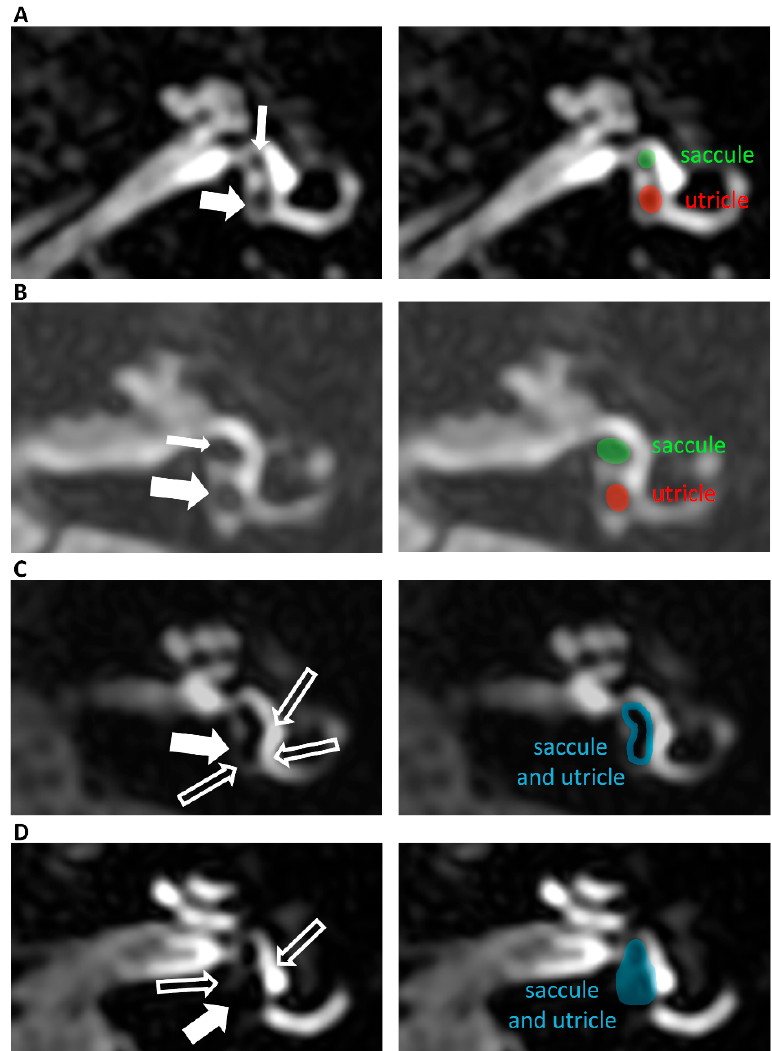
Figure 2. Delayed post-contrast 3D-FLAIR axial images of left ears below the mid-modiolar level (inferior part of the vestibule). The right side images on panel ( A – D ) show the same images as the left ones in respective panels but in the form of companion scans with some line art applied to define specific anatomical structures for easier identification of observed pathologies. Panel ( A ) presents a normal vestibule—grade 0 where non-enhancing the saccule (thin arrow) and utricle (thick arrow) are easily visible in the enhancing vestibule. The saccule is smaller than the utricle. Panel ( B ) presents extra low-grade, that is, grade 1 vestibular endolymphatic hydrops on Bearnaerts scale (but still grade 0 on Barath scale) where the saccule (thin arrow) and utricle (thick arrow) are well separated; however, the saccule is larger than the utricle, and the enhancing vestibule is seen around them. Panel ( C ) shows grade 2 vestibular endolymphatic hydrops on Bearnaerts scale (grade 1 on Barath scale) where the saccule and utricle are enlarged and confluent (thick arrow); however, thin enhancing boundaries of the vestibule are seen around them (long “empty” arrows). Panel ( D ) shows grade 3 vestibular endolymphatic hydrops on the Bearnaerts scale (grade 2 on the Barath scale), where significant enlargement of the saccule and utricle is so pronounced that the vestibule is almost totally obliterated (thin “empty” arrow). The saccule and utricle are enlarged and confluent (thick arrow); however, thin enhancing boundaries of the vestibule are seen around them (thin “empty” arrows).